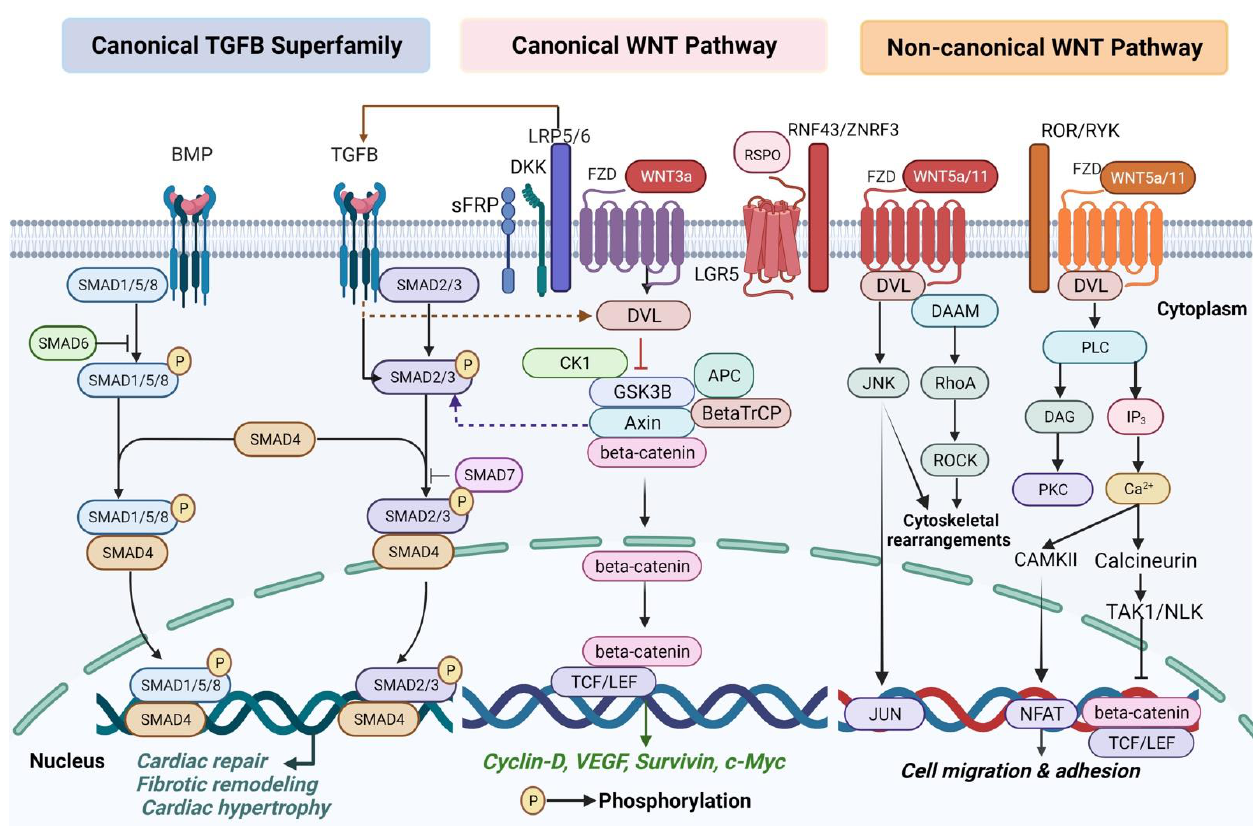
Figure 1. An illustrative representation of the interlinking networks between WNT and TGFB sig- naling pathways. In the sketch are delineated the intricate protein–protein interaction latticeworks within cardiomyocytes and telocytes, showing a complementary synergism to induce cardiomyo- genesis, cardiac regeneration, and pathogenesis of heart diseases. The figure is widely scrutinized in the main text. The black arrows designate main signaling pathways; the dashed arrows indicate activation; the continuous blunt-ended arrows pinpoint inhibition. APC: Adenomatous polypo- sis coli; BetaTrCP: Beta transducin repeats-containing protein; BMP: Bone morphogenetic protein; CAMKII: Calcium calmodulin-dependent protein kinase II; CK1: Casein kinase 1; DAAM: Disheveled- associated activator of morphogenesis; DAG: Diacylglycerol; DKK: Dickkopf; DVL: Dishevelled; FZD: Frizzled; GSK3B: Glycogen synthase kinase 3 beta; IP3: Inositol trisphosphate; JNK: c-Jun N terminal kinase; LGR5: Leucine-rich repeat-containing G-protein coupled receptor; LRP5/6: Lipopro- tein receptor-related protein 5/6; NFAT: Nuclear factor of activated T-cells; PKC: Protein kinase C; PLC: Phospholipase C; RNF43: Ring finger protein 43; ROCK: Rho-associated protein kinase; RSPO: R-spondin; SMAD: Small mothers against decapentaplegic; TAK1/NLK: Transforming growth factor beta-activated kinase 1/Nemo like kinase; TCF/LEF: T cell factor/Lymphoid enhancer factor; TGFB: Transforming growth factor beta; sFRP: Secreted Frizzled-related proteins; ZNRF3: Zinc and ring finger protein 3. Created with https://biorender.com/, accessed on 30 April